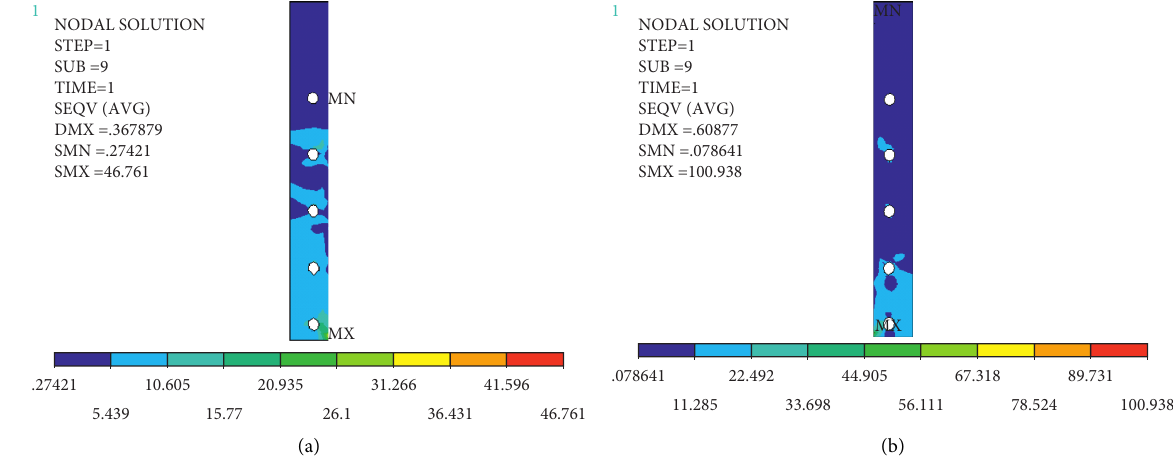
Figure 14: von Mises stress distribution of the end plate (MPa). (a) Midspan. (b) Side span.